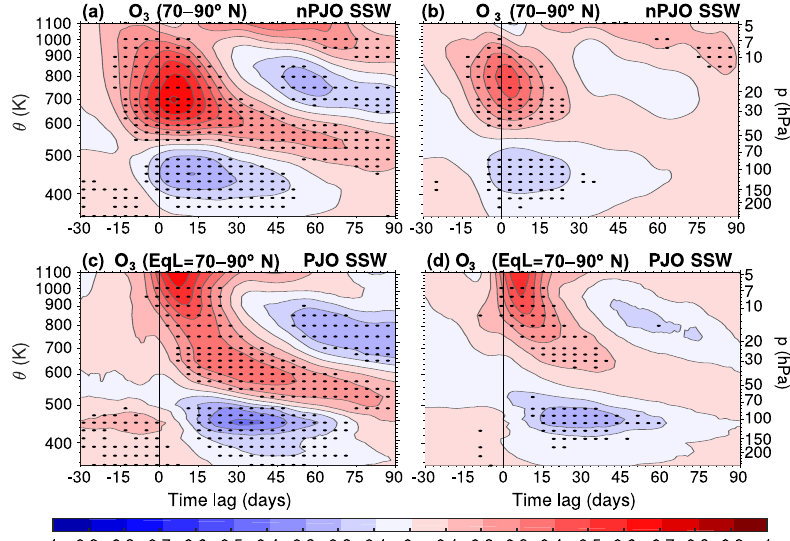
Figure 7. As in Fig. 3, but for PJO SSW and nPJO SSW events in WACCM.